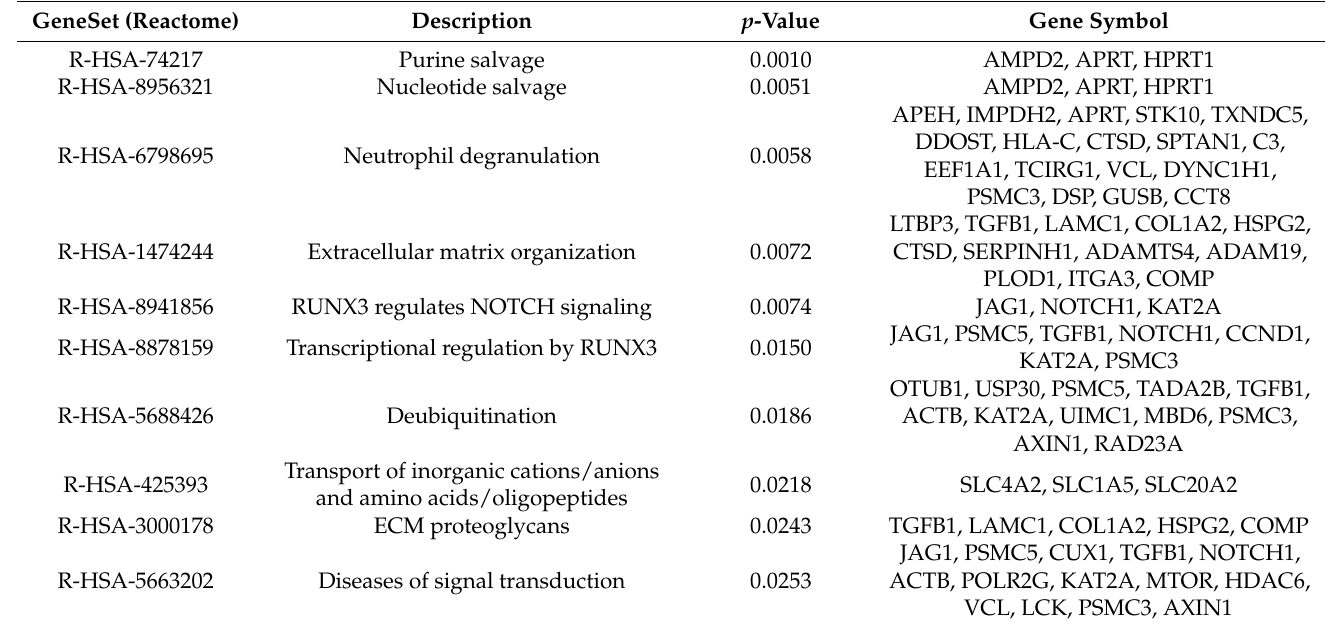
Table 3. Top 10 identified gene sets in the WebGestalt analysis for DIRAGs higher reactive in seroposi- tive (A) and seronegative RA (B) and PIA animals (C) during the disease onset period (24 days after pristane induction). Reactome GeneSet and link to the Reactome pathway browser, gene set description, the respective p -value and GeneSymbols of significantly higher reactive DIRAGs are